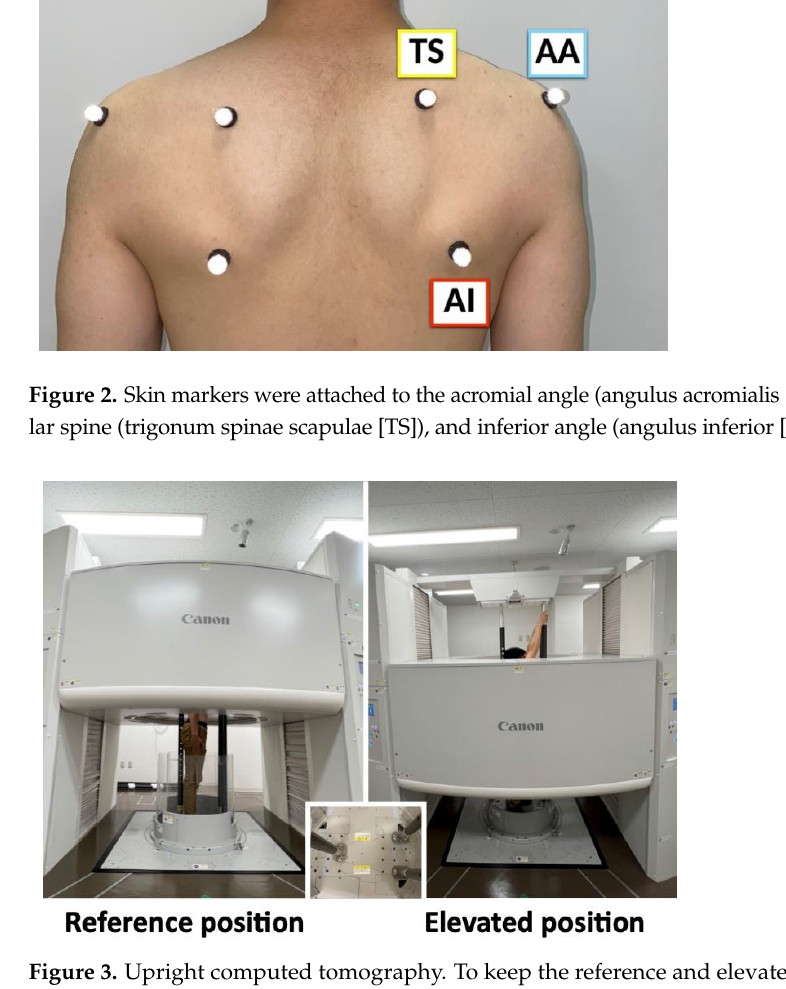
Figure 3. Upright computed tomography. To keep the reference and elevated positions during the scanning, three vertical poles were installed in the gantry.